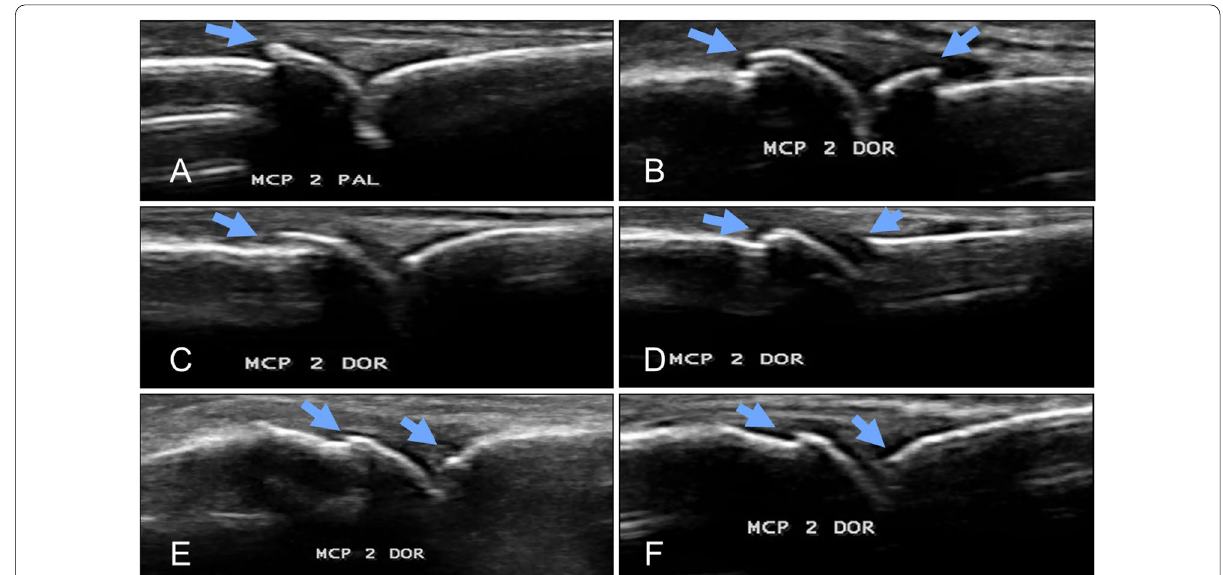
Fig. 1 Grading of osteophytes. Grading of OA signs in the longitudinal section plane: Grade III (severe) was defined as at least two osteophytes ( a , b ); Grade II (moderate) was defined as the availability of isolated small osteophytes ( c , d ); Grade I (discrete) was as uneven joint surface ( e , f